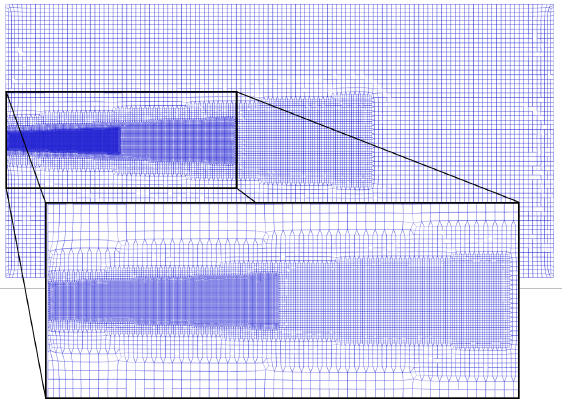
Figure 2. Cut through computational mesh visualizing refinement levels.